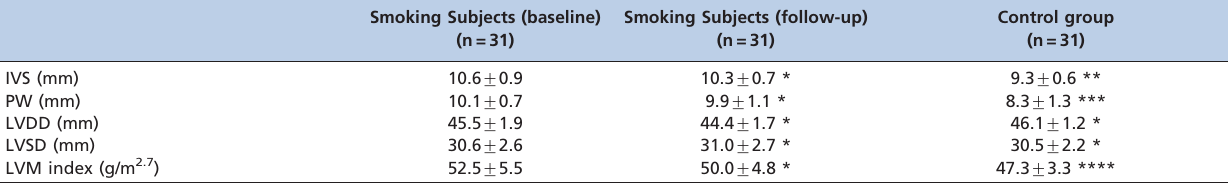
Table 4 - Echocardiographic